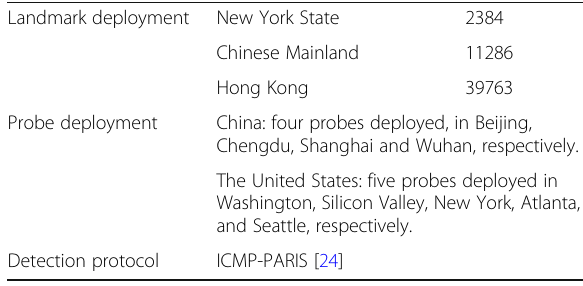
Table 1 Experimental setups Landmark deployment